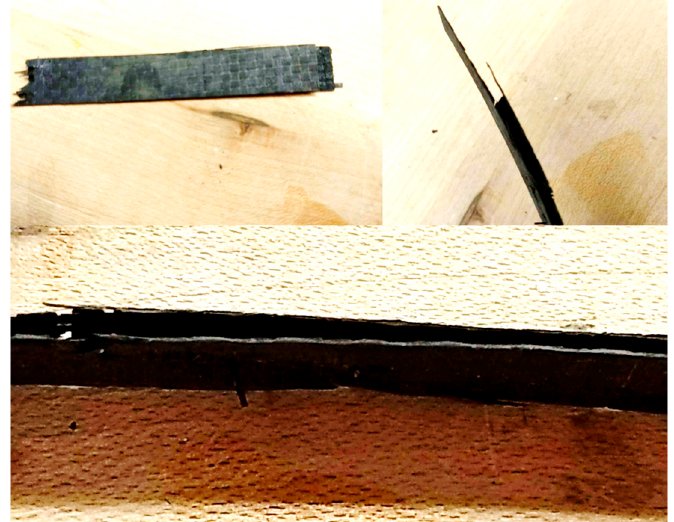
Figure 7. Delamination in composites based on carbon fibers and Bucky paper without ZnO nanorods.